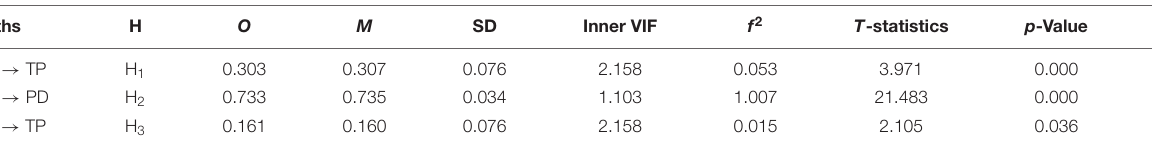
FIGURE 3 | Output of structural model (simple model). TABLE 7 | Direct effects.